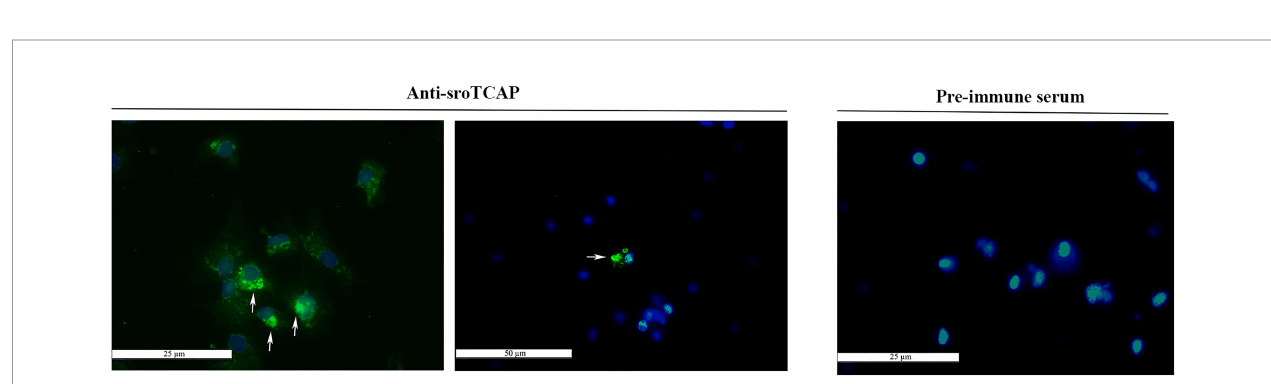
FIGURE 4 | Localization of TCAP in SRO hemocytes. Left and middle: TCAP detected in the cytosol of hemocytes and in granule-like bodies (white arrows) showing 25 and 50 µm scale bar respectively. Right: No fl orescence was observed when pre-immune serum was used, scale bar 25 µm. Green signal: ir-TCAP. Blue signal: DAPI stained